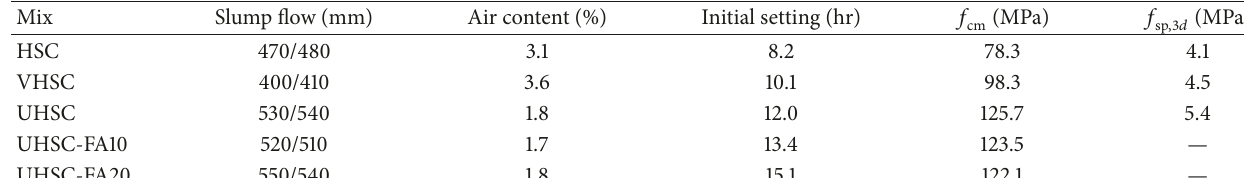
Table 2: Properties of fresh and hardened concrete .